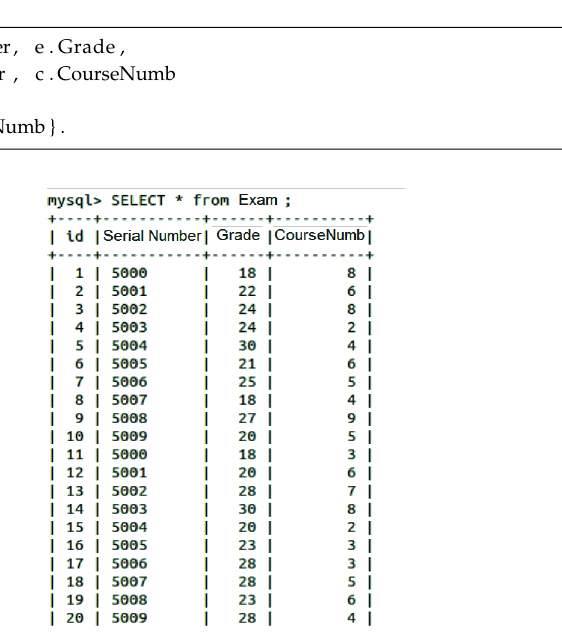
Figure 7. Example table “Exam” on MySQL.